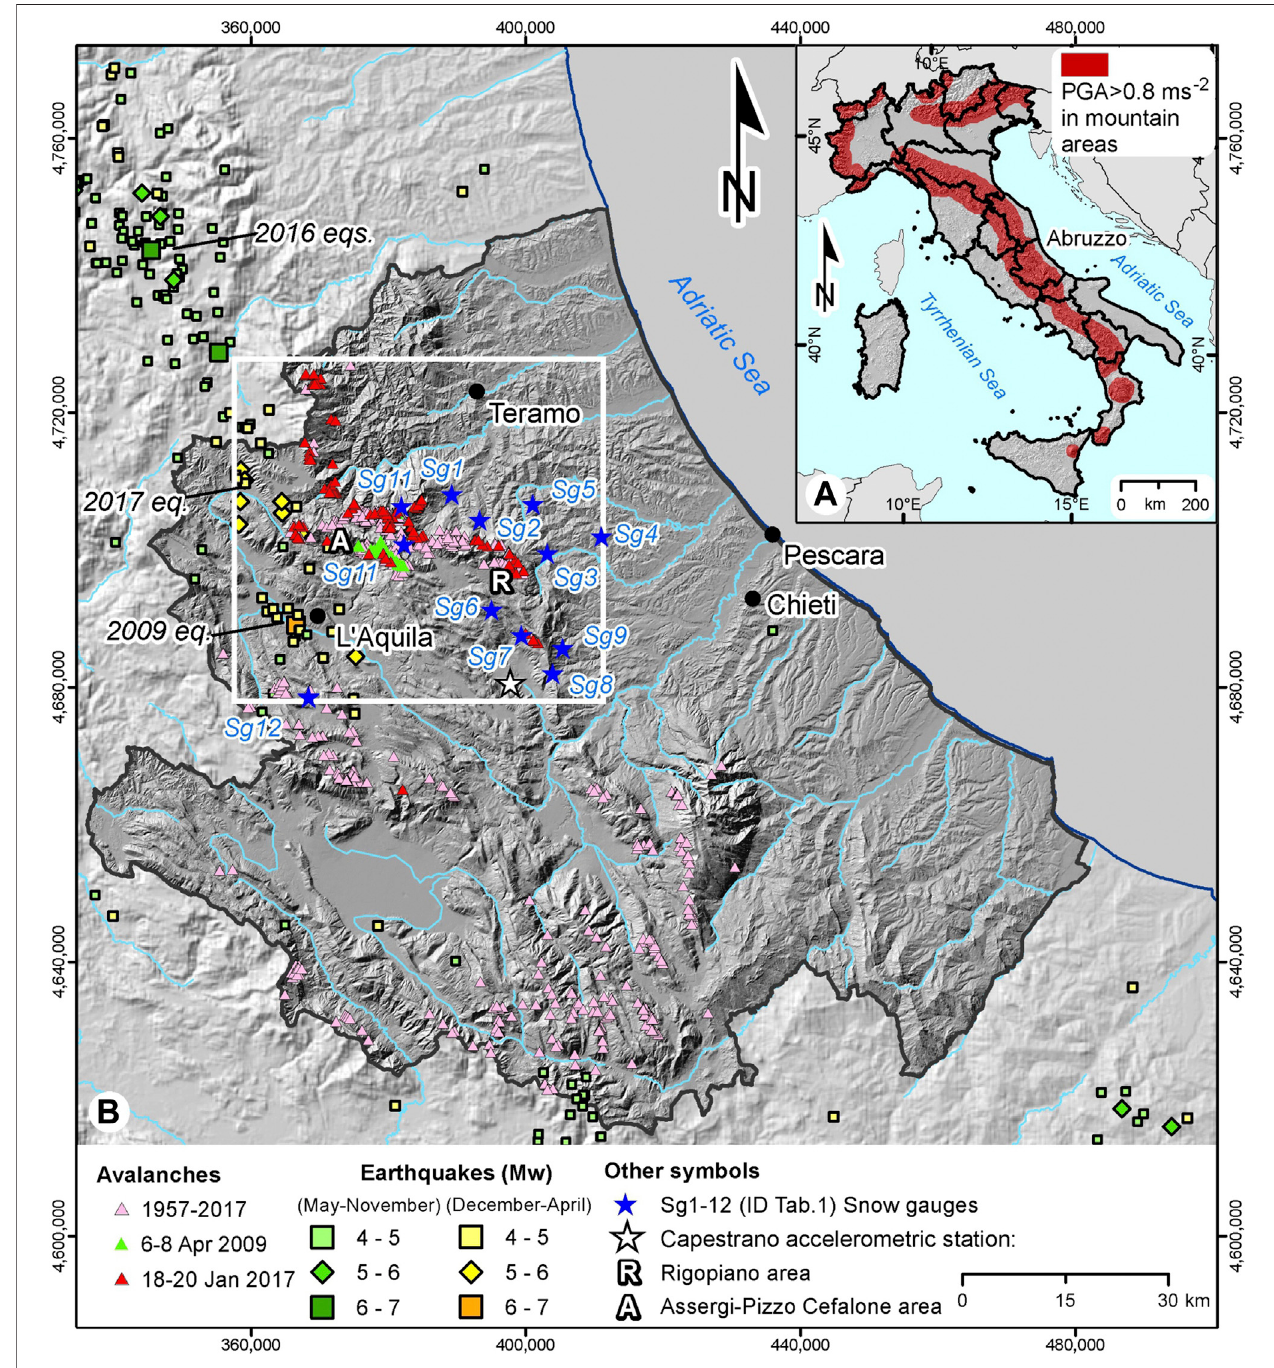
FIGURE 2 | (A) Detail of the Italian distribution of expected seismically induced avalanches according to Podolskiy ’ s global analysis (Podolskiy, 2010; Podolskiy et al., 2010a). Red indicates mountain areas affected by high snow cover and moderate-to-high seismic hazard (PGA > 0.8 ms − 2 ) (Stucchi et al., 2004). (B) Hillshade image of the Abruzzo region and location map (white box) of the area affected by avalanches in April 2009 and January 2017. Avalanches data were derived from the snow avalanche inventory of the State Forestry Corps of Italy, from local chronicles, eyewitness reports, a fi eld survey, and the Historical Avalanches Map of Abruzzo. Distribution of the recent historical avalanches (1957 – 2018) and seismicity (1950 – 2018) in the Abruzzo region. Earthquakes (Mw > 4) in winter (i.e.,December – April)aremapped(yellow-orangesymbols)aswellthethoseinspringtoautumn(i.e.,May – November;greensymbols).See SupplementaryAppendix A for details (INGV, 2016; Rovida et al.,